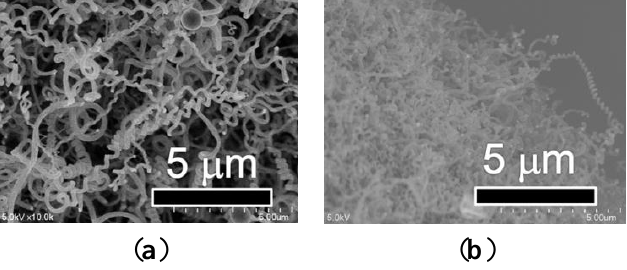
Figure 4. Cross-sectional SEM micrographs of deposits including CNC and carbon layers obtained at spin-coating velocities of ( a ) 1000 and ( b ) 1500 rpm. The red and blue arrows represent the thicknesses of CNC and carbon layers, respectively.